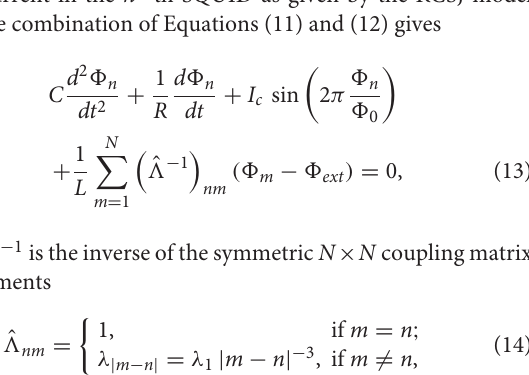
0.6. The other parameters are as in (A) . =